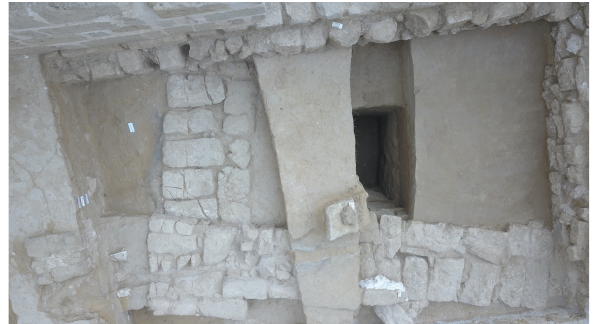
Figure 1 . Several superimposed occupations visible by the different orientations of the wall